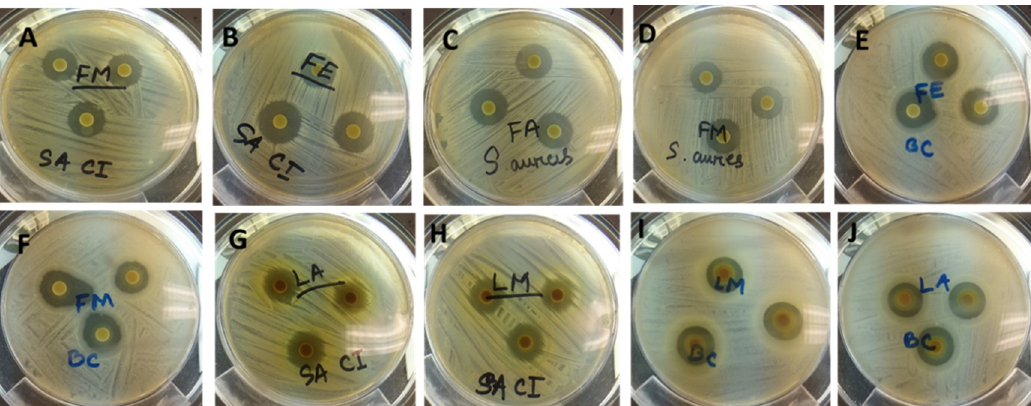
Figure 3. Antimicrobial activity (zones of inhibition) of ASE extracts of T. ferdinandiana tissues against various organisms. FM and FE against MRSA (A and B), FA and FM against Staphylococcus aureus (C and D), FE and FM against Bacillus cereus (E and F), LA and LM against MRSA (G and H), LM and LA against B. cereus (I and J). FM; Fruit methanol extract, FE; Fruit ethanol extract, FA; Fruit acetone extract, LA; Leaf acetone extract, LM; Leaf methanol extract; MRSA; Methicillin resistant Staphylococcus aureus.